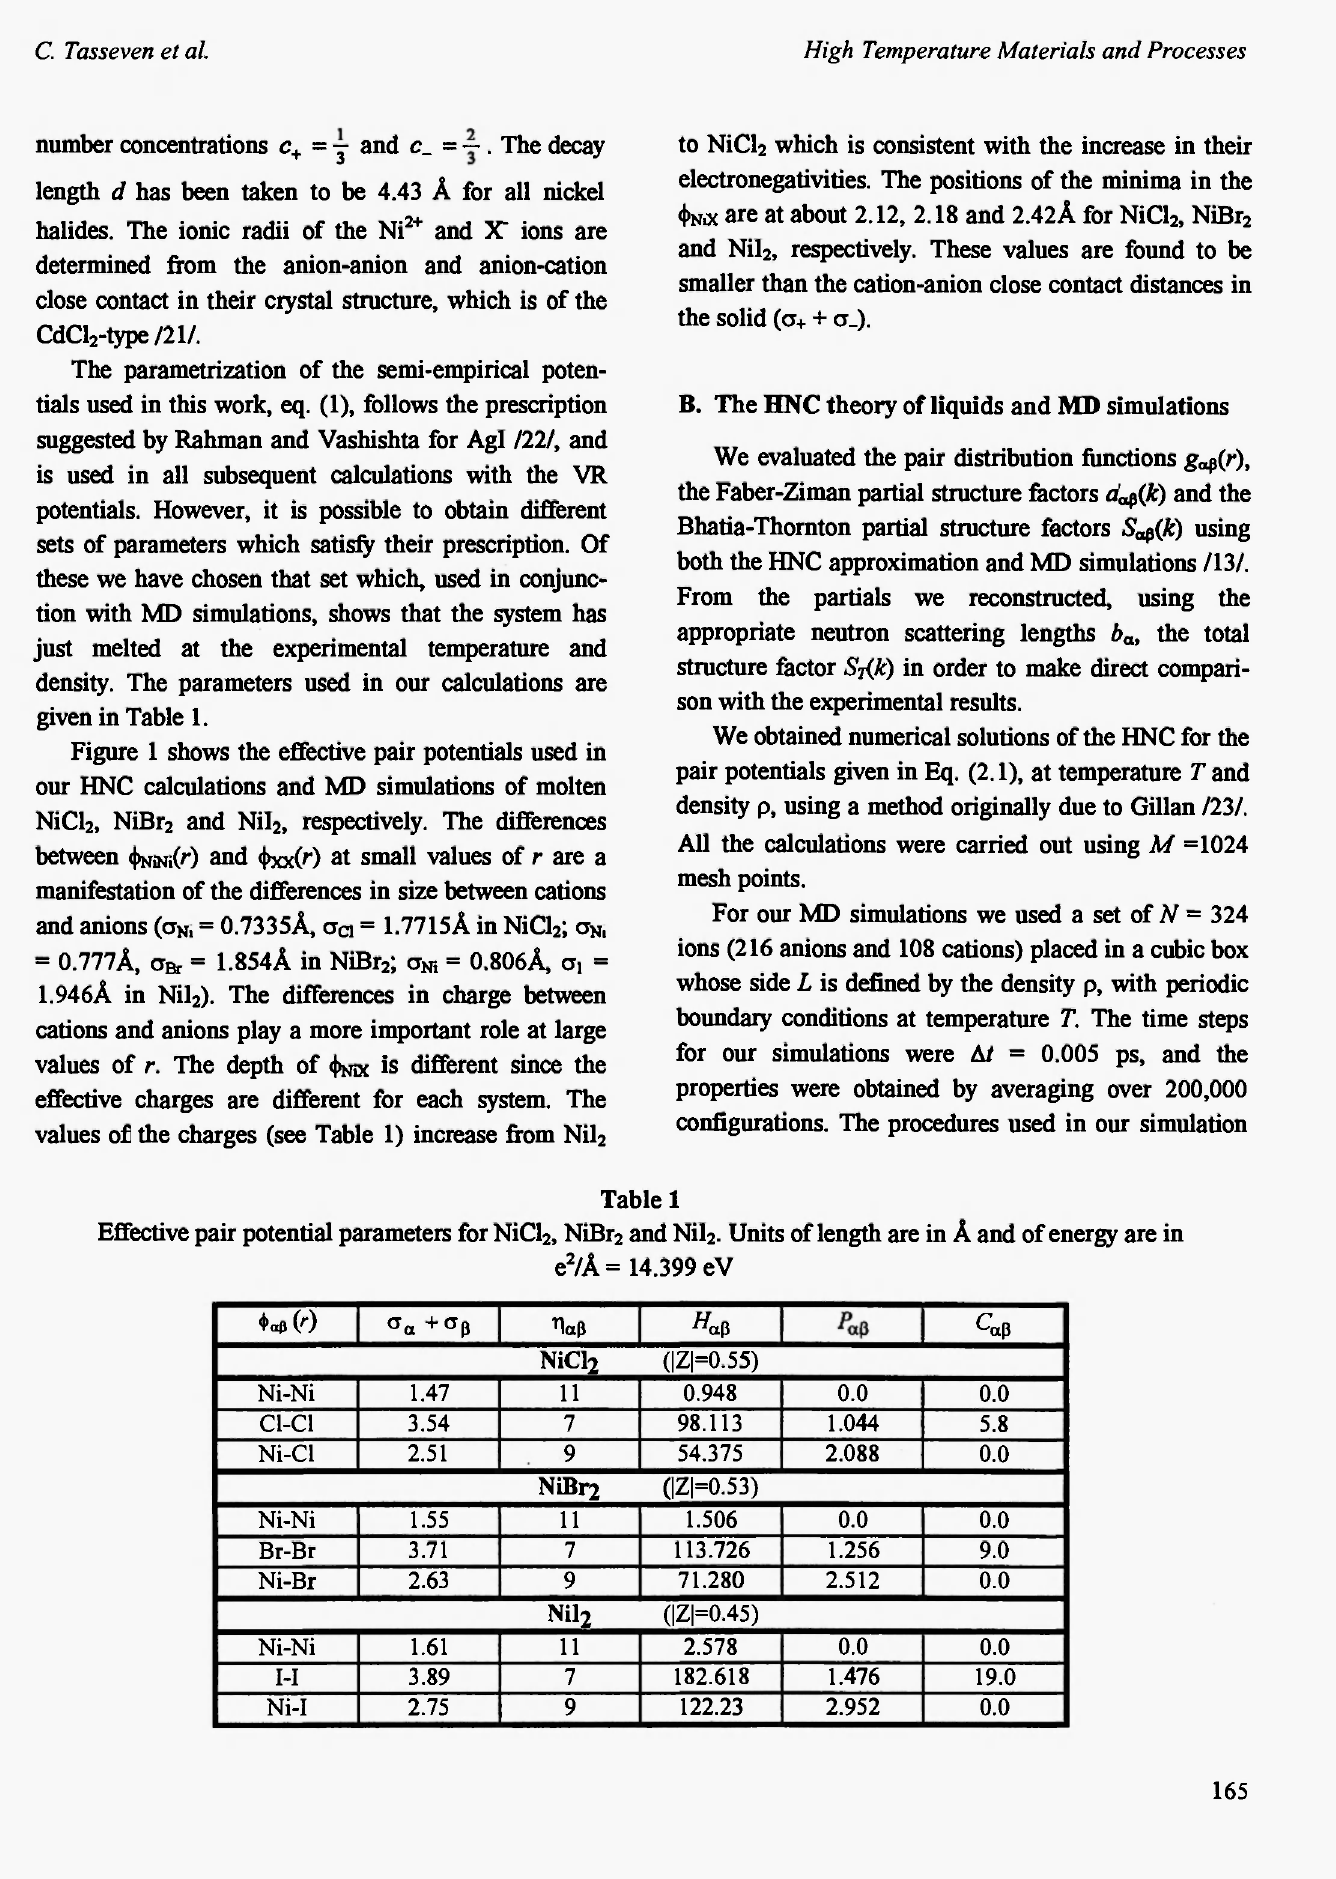
Effective pair potential parameters for NiCl